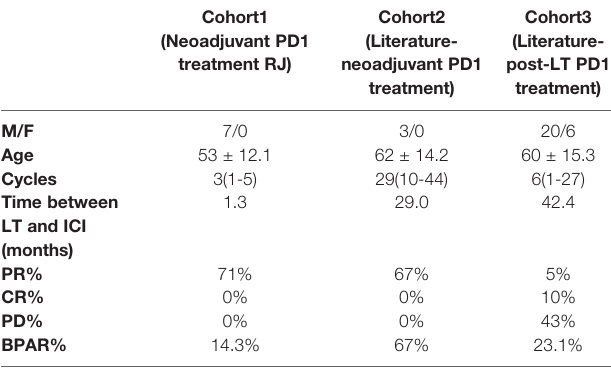
TABLE 1 | Comparison of patients ’ clinical characteristics in three cohorts.